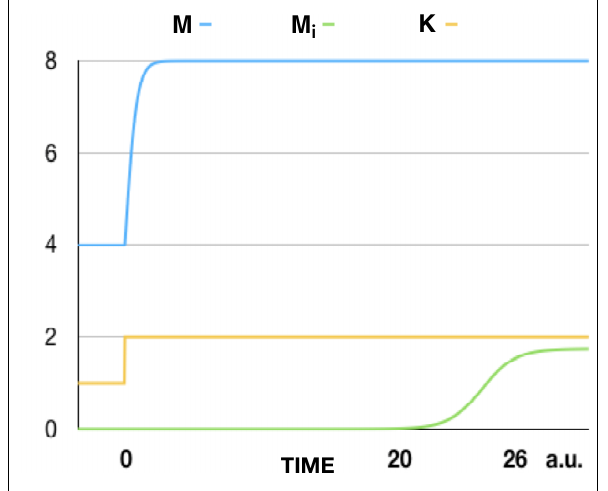
Figure 3. The total number of mice ( M ) , infected mice ( M i ) , and carrying capacity K as a function of time t for a = 0.8, b = 5, and c = 1. The carrying capacity changes discontinuosly from K = 1 (below the threshold) to K = 2 (above the threshold) at t = 0. The total number of mice grows from M = 4 to M = 8 in a short time after t = 0. The number of infected mice, instead, begins to grow from a vanishing value after a time t = 20 and, then, grows until the stationary value M i = 1.75. This graph presents evidence for a delay in the bifurcation of M i . In fact, M i begins to grow much later than the time at which M and K arrive at their steady-state